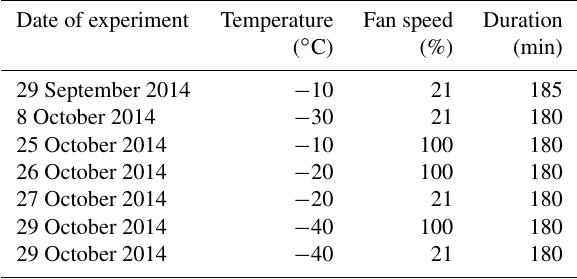
Table 2. Experiments selected to characterise the chamber temper- ature uniformity during the CLOUD9 campaign. The experiments were selected to have 3h periods at various temperatures during which no changes were made to gases or other